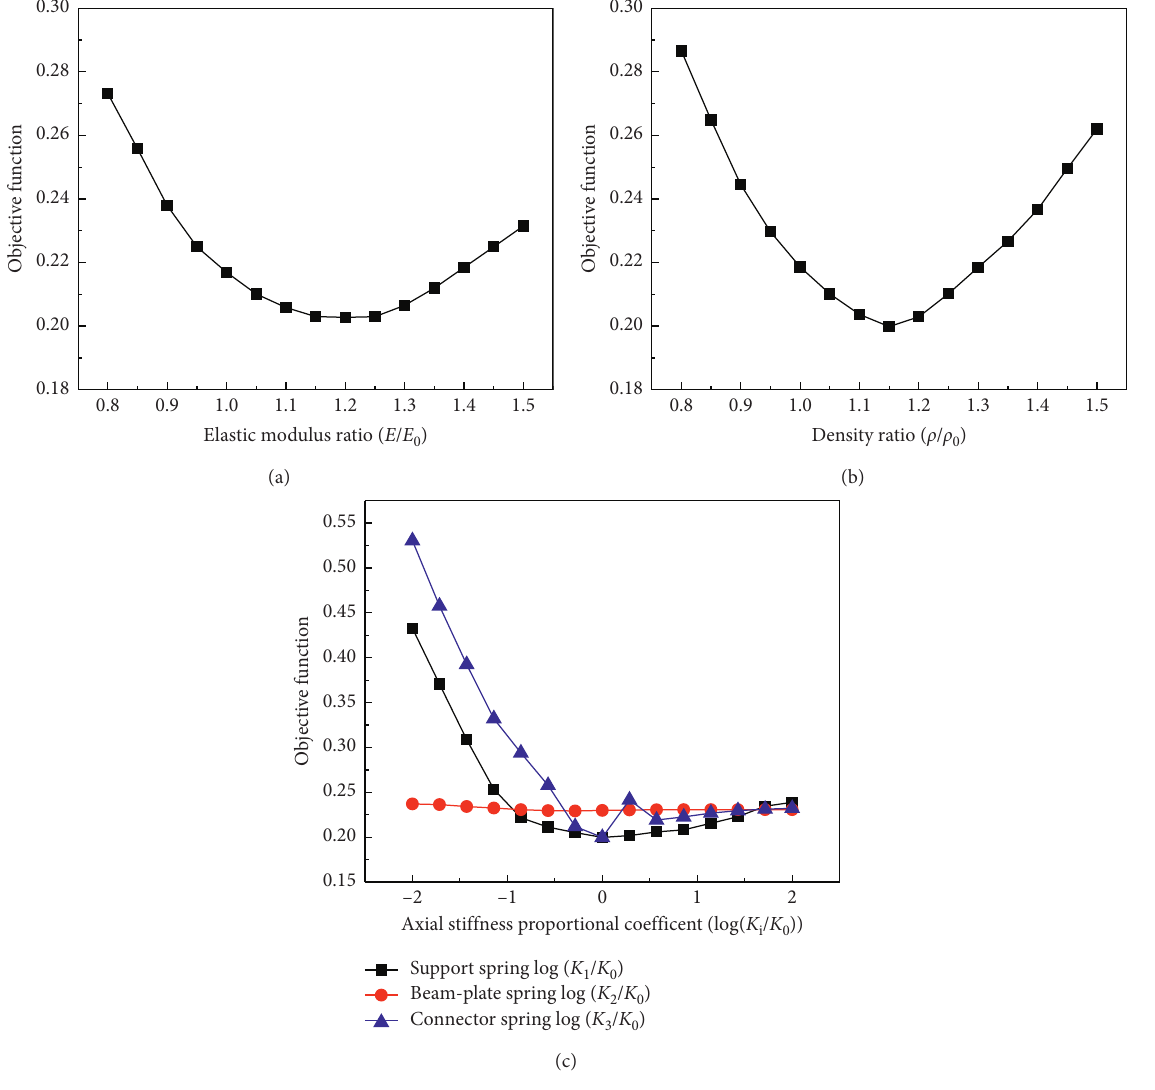
Figure 18: Physical parameter sensitivity analysis using dynamic data: (a) elastic modulus of the concrete; (b) density of the concrete; (c) axial stiffness of the